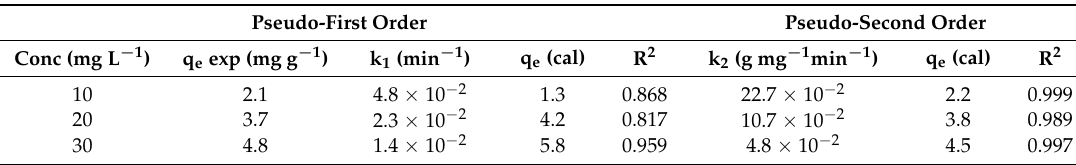
Table 1. Kinetic parameters of Pb(II) adsorbed onto ZnO-Nano-A.